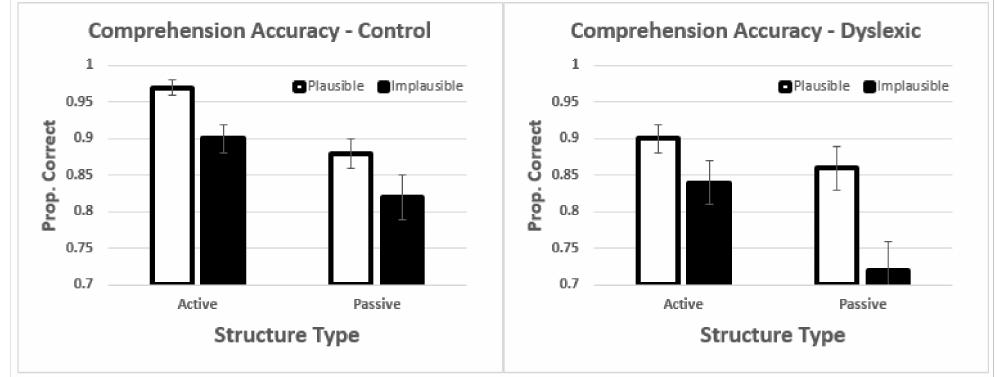
Figure 2. Mean comprehension accuracy. Error bars show the standard error of the